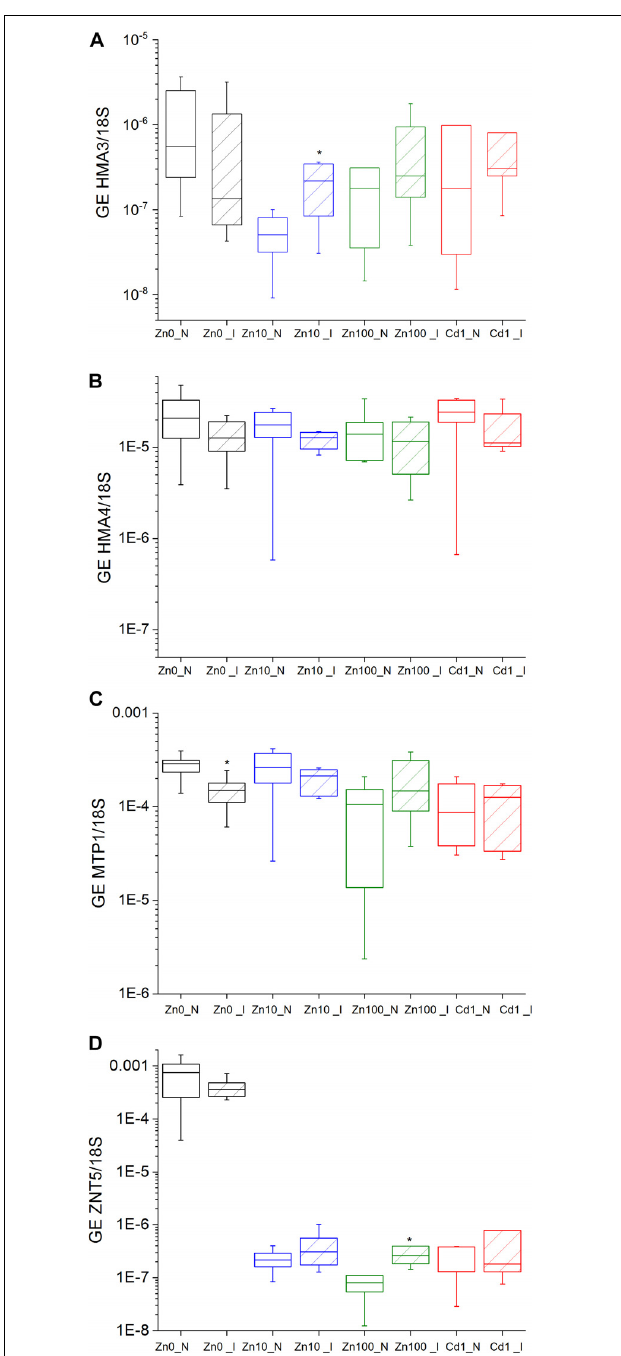
FIGURE 5 | Expression of metal transporter genes normalized to 18S in the leaves of N. ochroleucum plants calculated according to Pfaffl. Zn0 (A) , Zn10 (B) and Zn100 (C) refer to Zn concentrations used in the treatments (‘0’ = 0.01, 10 and 100 µ M Zn), Cd1 (D) refers to 1 µ M Cd + 10 µ M Zn treatment. N – non-infected – empty box plots. I – infected – box plots with stripes. The line presents the median value ( n = 6–8), the box shows the values between the 0.25–0.75 percentiles, and the bars show whiskers with 1.5 coefficient for outliers. Asterisks denote significant differences between infected and non-infected plants within the same Zn treatment according to the Mann–Whitney